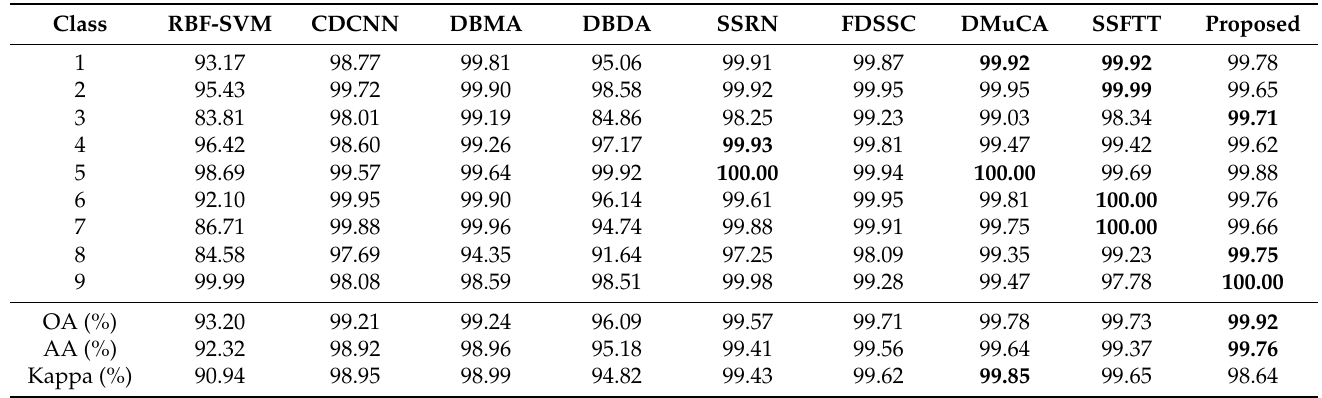
Table 6. Classification results of the Pavia University dataset using 5% training